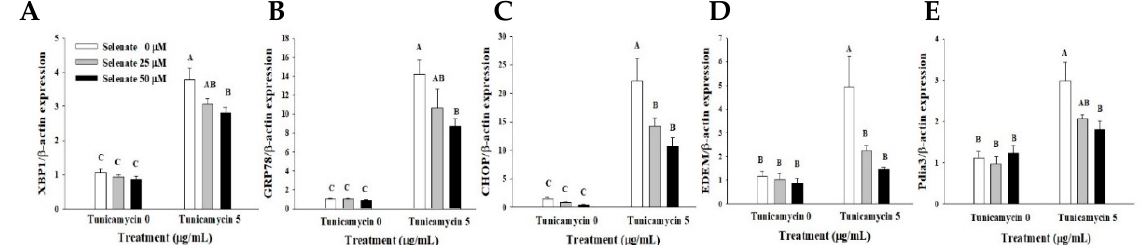
Figure 7. Selenate treatment suppresses tunicamycin-induced endoplasmic reticulum (ER) stress. After 24 h of pretreatment with 25 and 50 µ M selenate in one-day post-confluent 3T3-L1 preadipocytes, the cells initiated differentiation during Day 0–2 in the absence of selenate. On Day 2, the levels of ER-stress related genes XBP-1 ( A ), GRP78 ( B ), CHOP ( C ), EDEM ( D ), and Pdia3 ( E ) had their levels determined using quantitative RT-PCR. Different characters indicate a significant difference at p < 0.05.